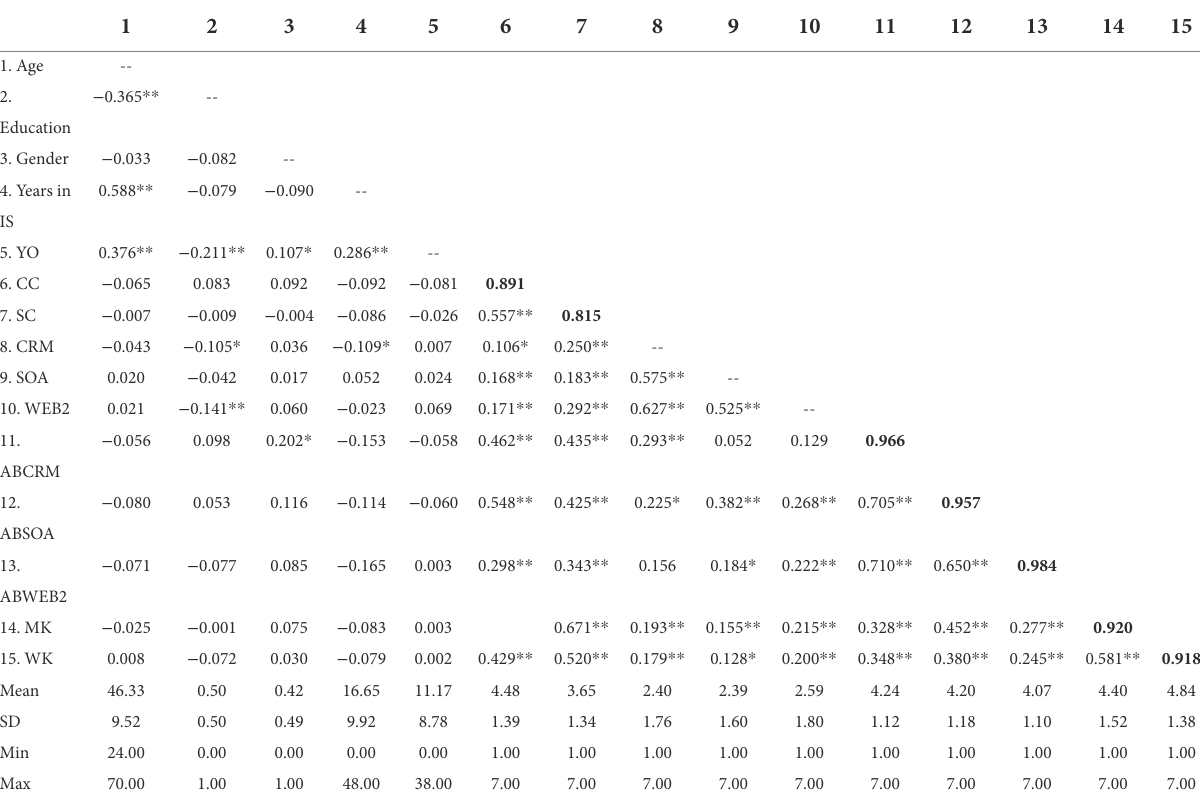
TABLE 3 Descriptive statistics, correlations, and square root of AVE, (Sample Size: